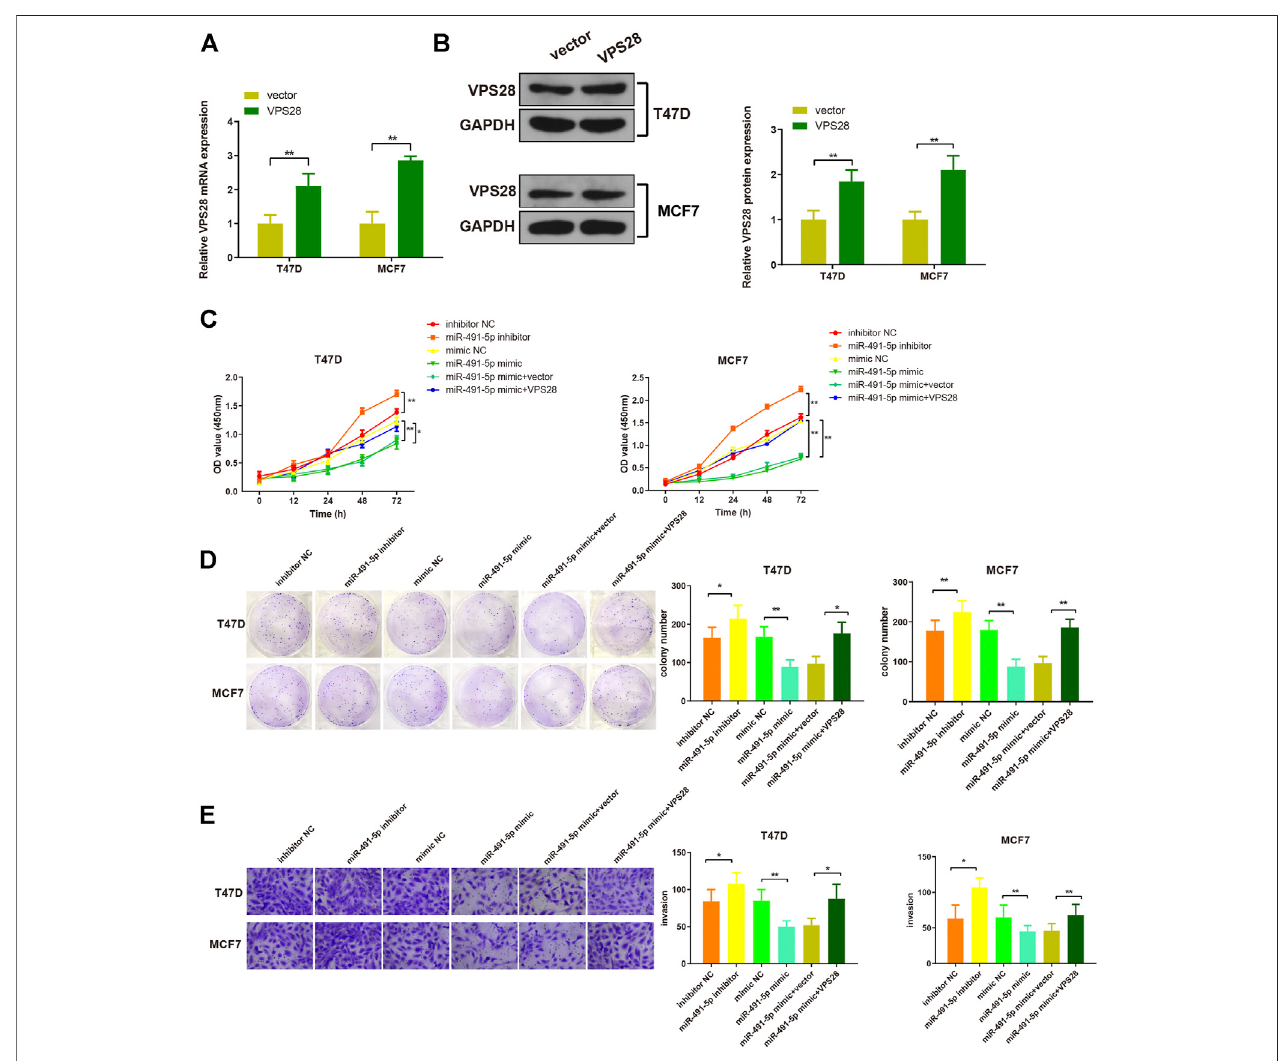
FIGURE 7 | Micro RNA-491-5p suppresses the proliferation and invasion of breast cancer cells through the regulation of VPS28 . VPS28 overexpression was achieved in breast cancer cells whose transfection ef fi ciency was determined by qRT-PCR (A) and Western blotting (B) . Cell viability, proliferation, and migration ability were detected by MTT (C) , clone formation assay (D) , and scratch assay, respectively (E) . * p < 0.05, ** p < 0.01, n (cid:1) 3.